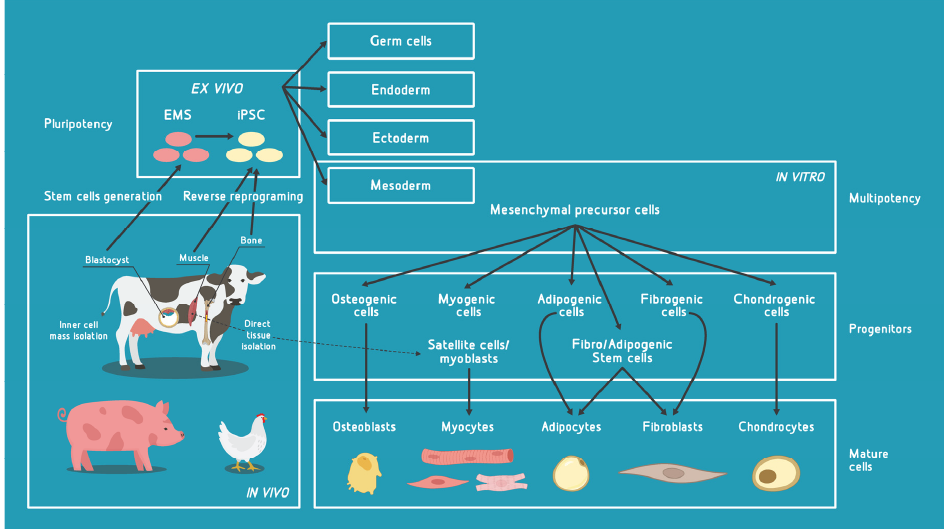
Figure 1. Major cell types of interest for CM